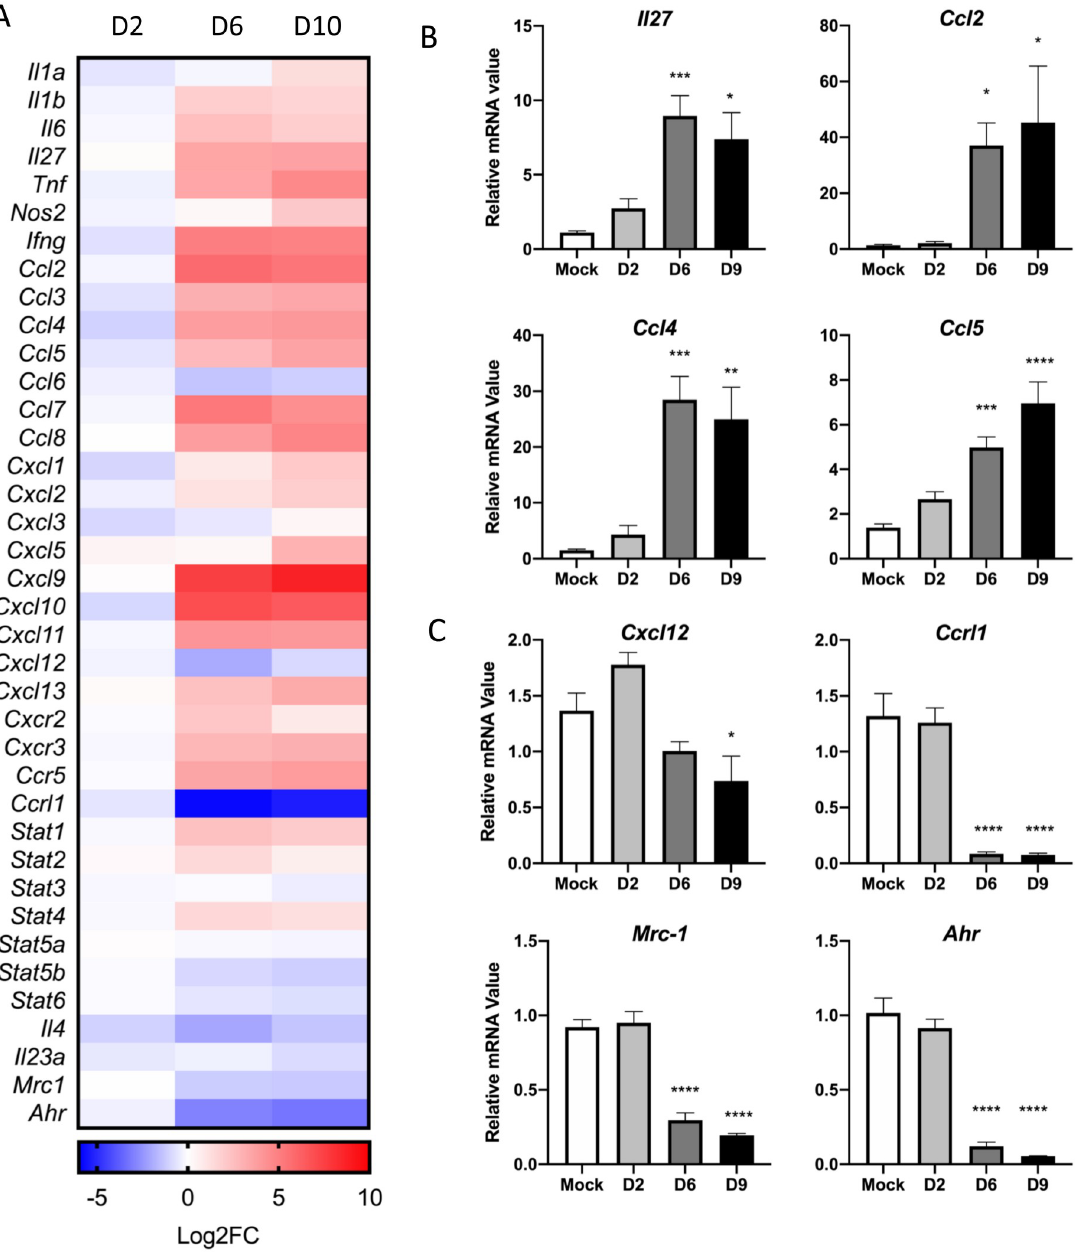
Fig 5. Activated type-1, but suppressed type-2, gene activation during severe disease. (A) Nanostring gene profiling analysis was performed on lung tissue homogenates of mock and lethally infected mice, as in Fig 1. The kinetic expression data in Log2Fold change compared to the mocks for relevant cytokines/chemokines and key inflammatory markers are shown. (B) Novel findings were validated by using qRT-PCR to detect type 1/proinflammatory markers, and (C) type 2 markers from whole lung tissue homogenates of infected mice. Shown are representative data from 3 independent mouse infection experiments with similar trends. Data are presented relative to GAPDH values and shown as mean ± SEM. One-way ANOVA with Dunnett’s multiple comparison test was used for statistical analysis, with Mock samples used as reference. � , p < 0.05; �� , p < 0.01; ��� , p < 0.001; ���� , p < 0.0001.